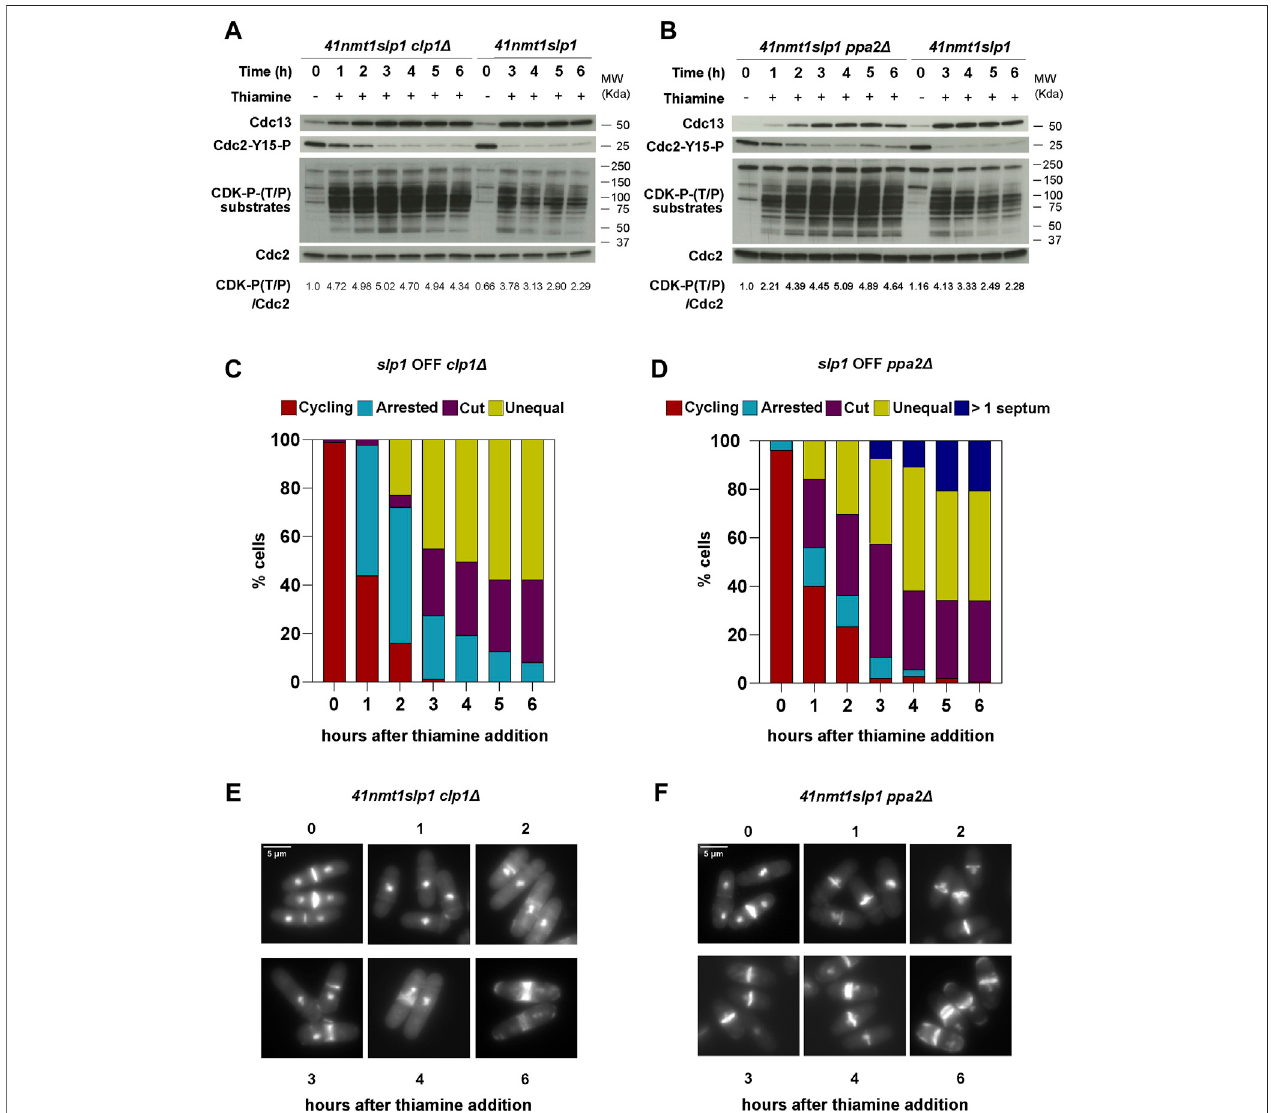
FIGURE 2 | Protein phosphatases in fl uence the mitotic arrest. (A – F) cells were grown exponentially in EMM ( p41-nmt1 promoter induced) and shifted to EMM +T ( p41-nmt1 promoterrepressed)at30 ° C.Sampleswerecollectedattheindicatedtimepointsformicroscopyandwesternblot. (A,B) Cdc13levels,phosphorylationatT/ P sites in CDK substrates and Y15-Cdc2phosphorylation in p41-nmt1:slp1 and p41-nmt1:slp1 clp1 Δ (A) or p41-nmt1:slp1 and p41-nmt1:slp1ppa2 Δ strains (B) were detected by western blot. Cdc2 (PSTAIR) was used as a protein loading control. The numbers under the western blot indicate CDK-substrate Phosphorylation (P-T/P) quanti fi cation relative to Cdc2. (C,D) The percentage of cycling cells, metaphase-arrested cells, and arrested cells that underwent cytokinesis (cut or unequal) were determined at the indicated time points after the addition of thiamine to the culture. At least 200 cells were counted per time point. (E,F) Representative images of mitotic features distributions from DAPI and Blankophor-stained ethanol- fi xed cells in (C,D) . Scale bar 5 µm.